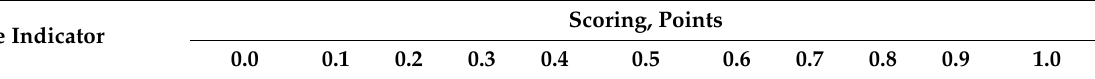
Table A1. Scoring of the indicator “The formation of an integrated approach to the organisation of the regional system in the